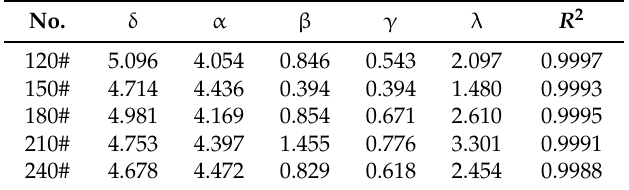
Figure 8. ( a ) Complex modulus (| G *|) master curve of the 180# fitted by the GLS model in the temperature range from − 35 to 120 °C; ( b ) Experimental data with the GLS model simulated function curves ( T ref = 30 °C). Table 2. Parameters fitted by the generalized logistic sigmoidal GLS model.